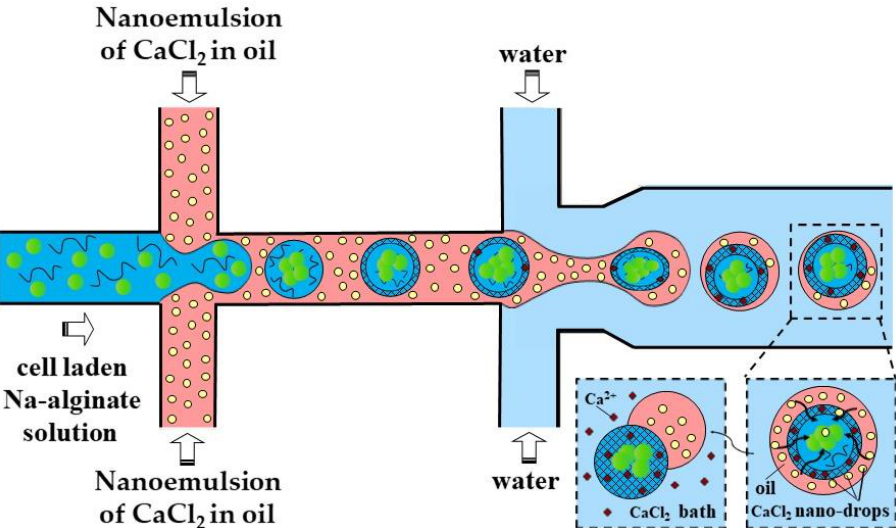
Figure 9. Formation of cell-laden calcium alginate beads using a two-step external gelation process within a double water/oil/water (W/O/W) emulsion. CaCl 2 nano-droplets in the shell penetrate inside the core droplets and cause their surface gelation, followed by complete gelation in a CaCl 2 gelation bath [44].